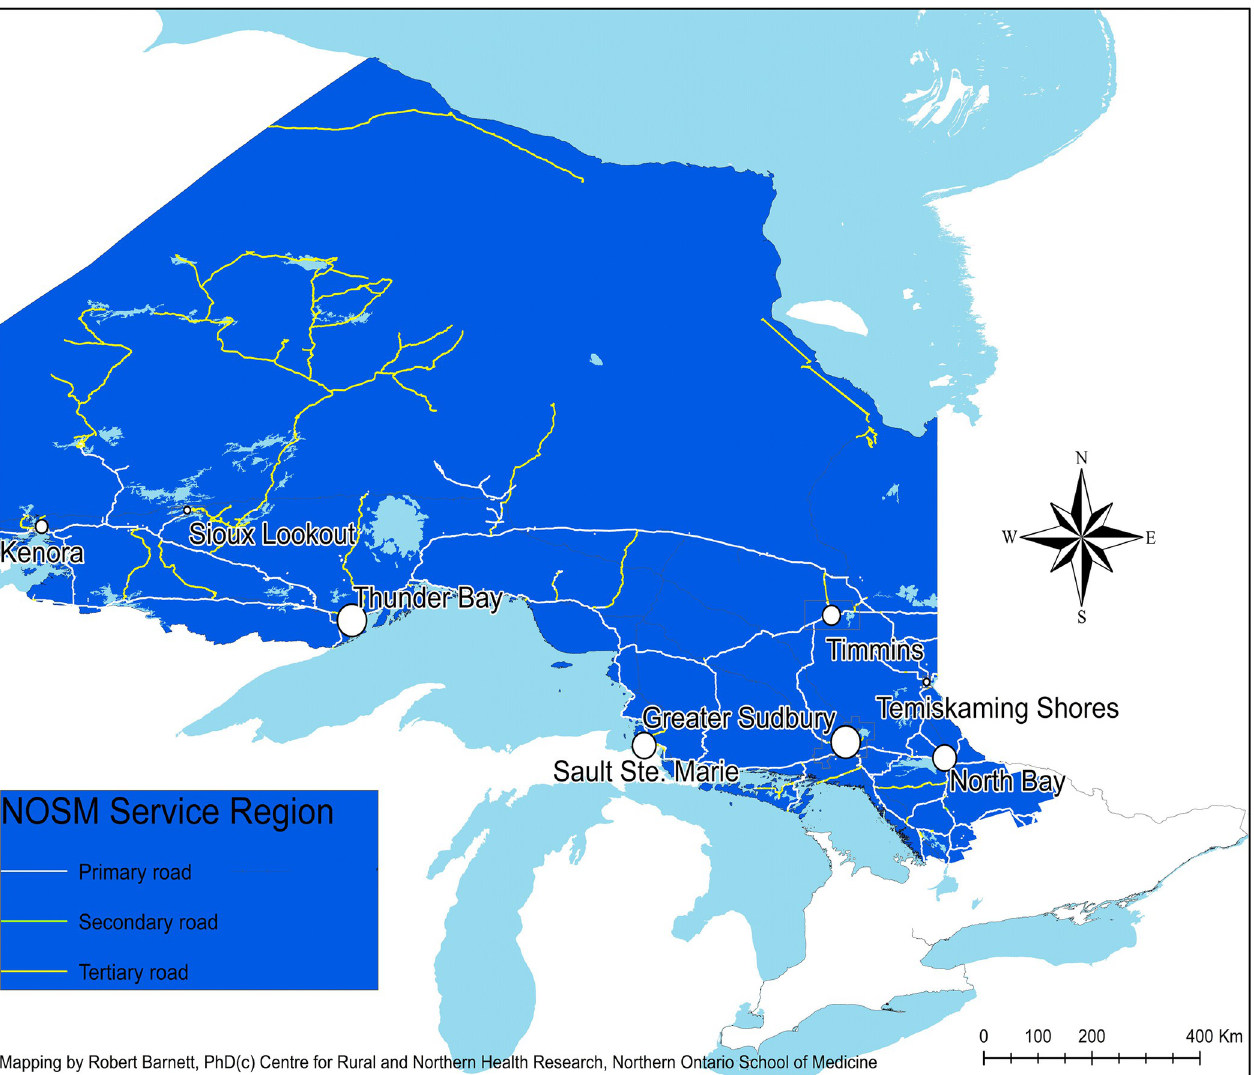
Fig 1. Map showing the major communities and transportation network in the service region of the Northern Ontario School of Medicine.